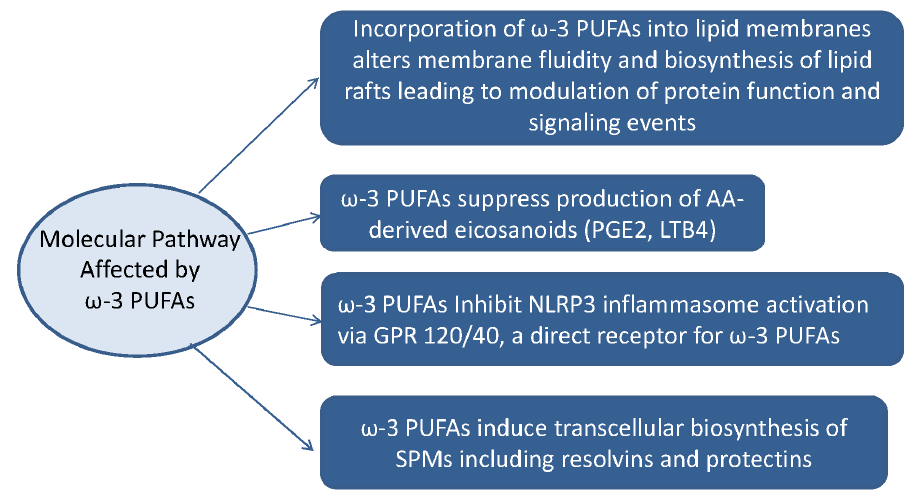
Figure 1. Molecular pathways affected by ω -3 PUFAs. AA: arachidonic acid; PGE2: prostagalandin E2; LTB4: leukotriene B4; GPR: G protein-coupled receptor; NLRP3: NACHT, LRR and PYD domains-containing protein 3; SPM: specialized pro-resolving mediator.